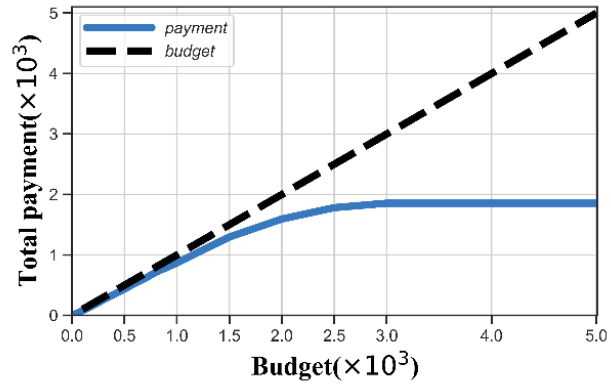
Figure 6. Payment versus budget.